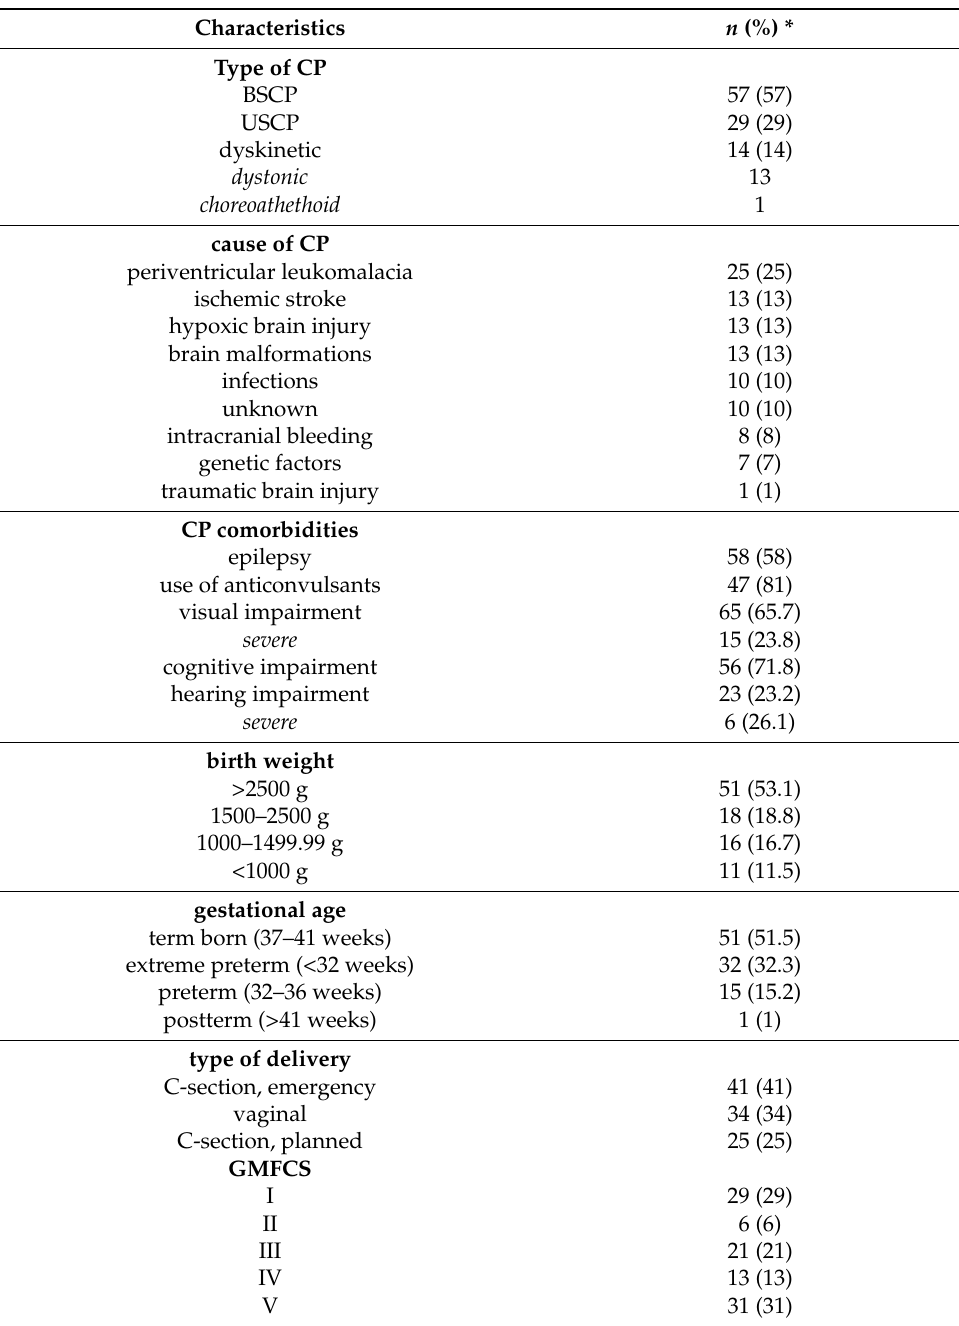
Table 1. Patient characteristics (N =